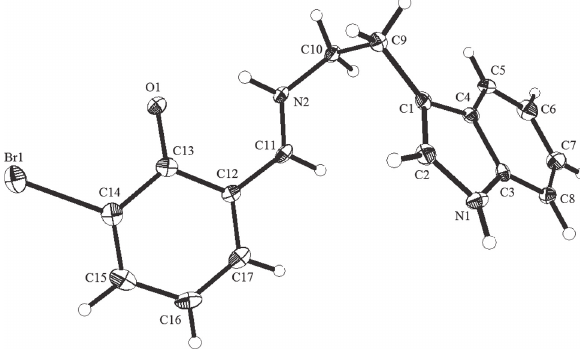
Table 1: Data collection and handling.